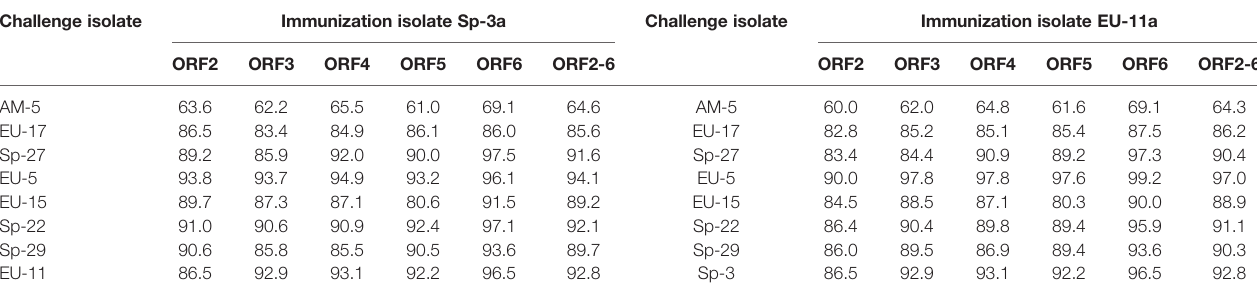
TABLE 2 | Pairwise comparison of the nucleotide sequences of ORFs 2, 3, 4, 5, 6 and 2-6 of the PRRSV isolates used for immunization and challenge in Experiments A and